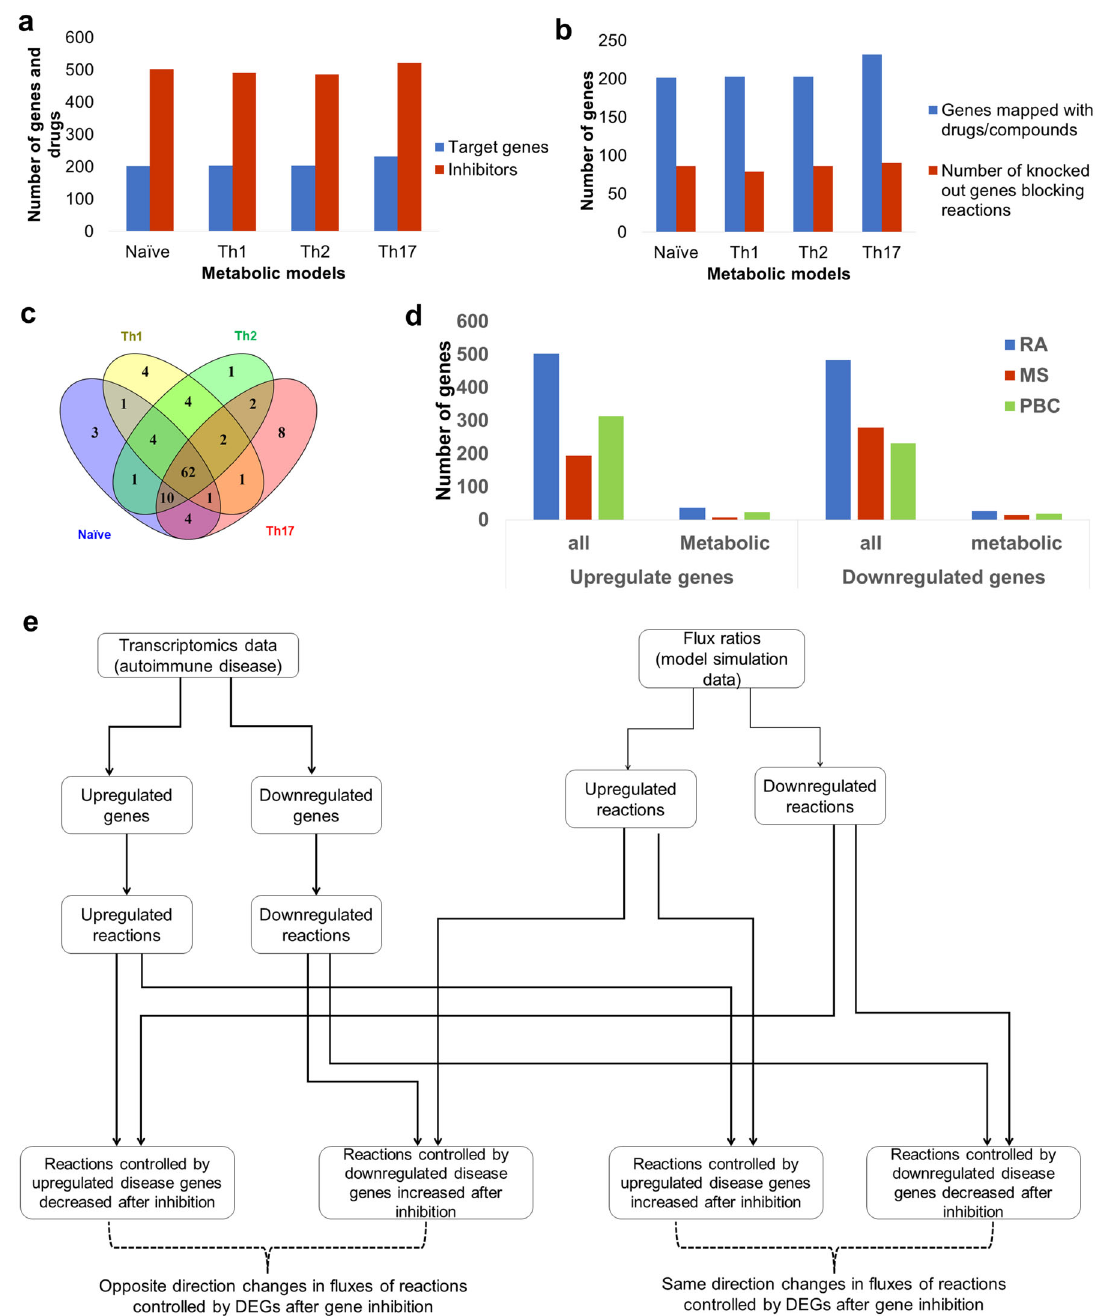
Fig. 5 Identi fi cation of potential drug targets for RA, MS, and PBC. a Distribution of metabolic drug target genes, and inhibitory drugs or compounds in each model. b Number of metabolic genes in the models mapped with inhibitory drugs (blue bars) and number of genes among drugs mapped genes that can block at least one reaction upon inhibition (red bars). c Comparison of metabolic drug targets that affect reactions upon deletion in CD4 + T-cell models. d Number of all differentially expressed genes (DEGs) and metabolic DEGs in three diseases rheumatoid arthritis (RA), multiple sclerosis (MS), and primary biliary cholangitis (PBC) ( P adj < 0.05). The DEGs were analyzed using three transcriptomics datasets (one dataset per disease). The data were obtained from peripheral CD4 + T cells of groups of patients and healthy individuals. e Schematic representation of the integration of disease-associated differentially expressed genes and affected reaction on each drug target gene perturbation. For each drug target deletion, we investigated how many of fl uxes regulated by upregulated genes are decreased and fl uxes regulated by downregulated genes are increased. We used these numbers to calculate PES (perturbation effect score, see Materials and methods). our model and analysis can be used to advance future drug experimental data, predicted target genes for which no data is repurposing as well as drug discovery efforts. currently available, and predicted drug targets for which we Our predictions include three genes ( DHODH , ACAT1, and DHFR ) provide experimental validation. We will discuss select examples that code for proteins targeted by approved drugs currently used of targets in each of these categories to illustrate ways in which Published in partnership with the Systems Biology Institute npj Systems Biology and Applications (2021)